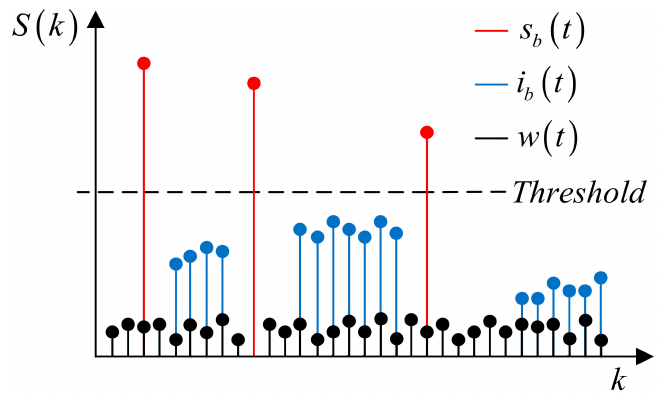
Figure 6. Fast Fourier Transform result of Equation (9). ( i (cid:54) = i m